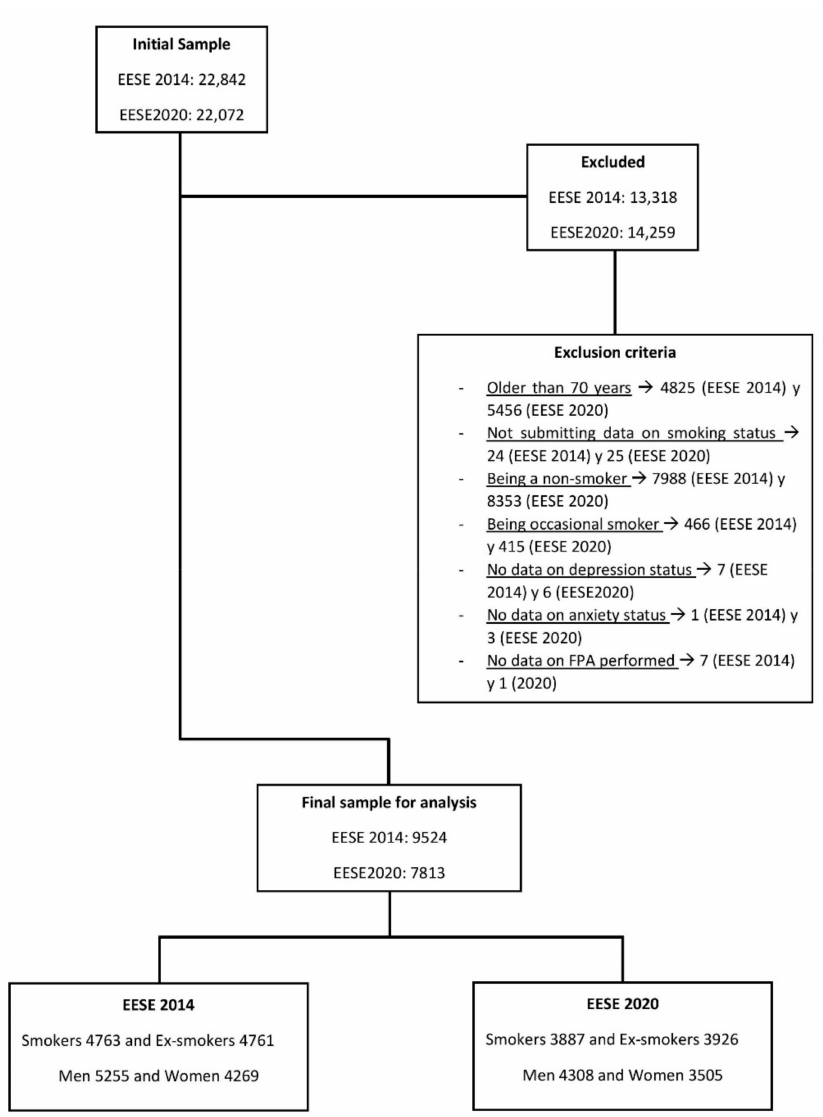
Figure 1. Sample exclusion criteria (sub-study